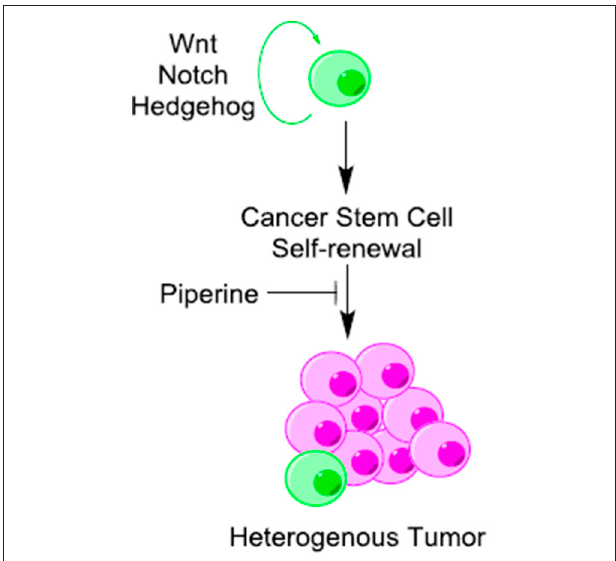
FIGURE 5 | Piperine is a potential inhibitor of cancer stem cells (CSCs) self-renewal. Piperine inhibits cancer stem cells (CSCs) self-renewal through its direct or indirect inhibitory influence on Wnt/ β -catenin, Hedgehog and Notch